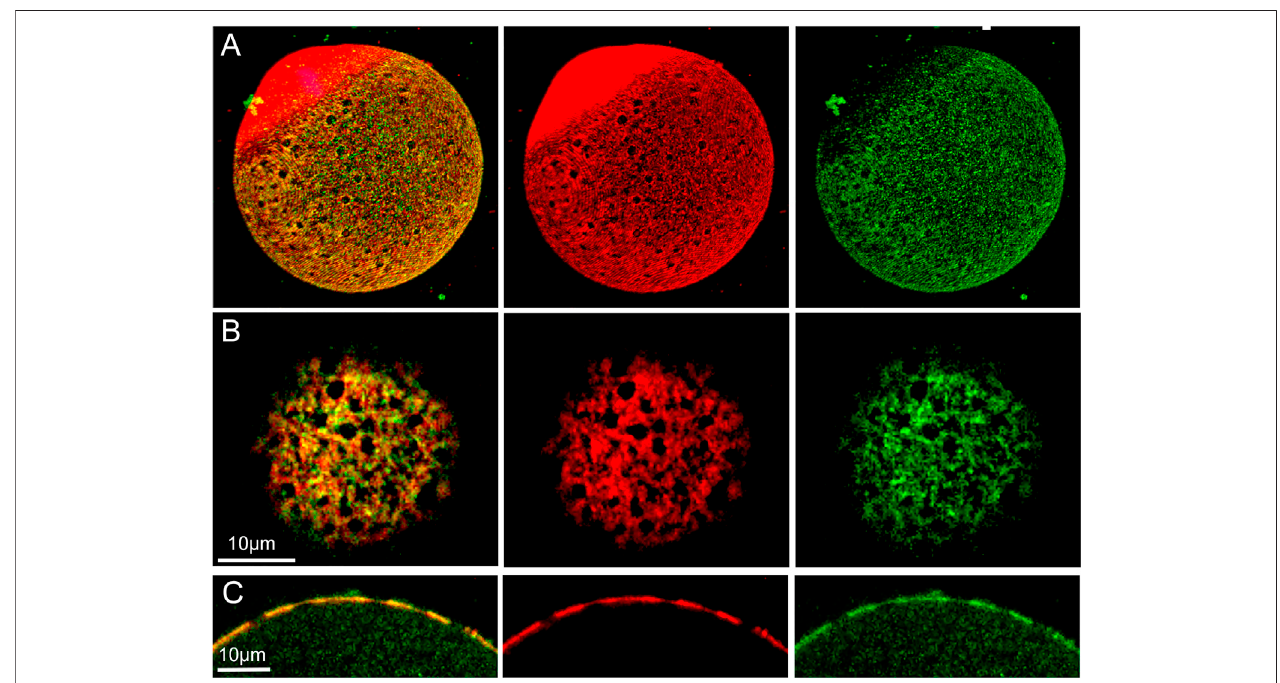
FIGURE 4 | Distribution of f-actin and β -catenin in the oocyte cortex.MII oocyte from a virgin female was treated by prolonged fi xation and labeled with anti- β - catenin (green) and Alexa Fluor-568 phalloidin (red) to label f-actin, as well as Hoechst 33342 (blue). Z-stack images viewed in volume mode (A) , a tangential image (B) , and an equatorial image (C) reveal fenestrae appearing as holes in the cortical actin layer (A,B) or as regions of thinner f-actin in the equatorial view (C) . Images were selected from 10 oocytes from three females. Magni fi cation is indicated by the bar.